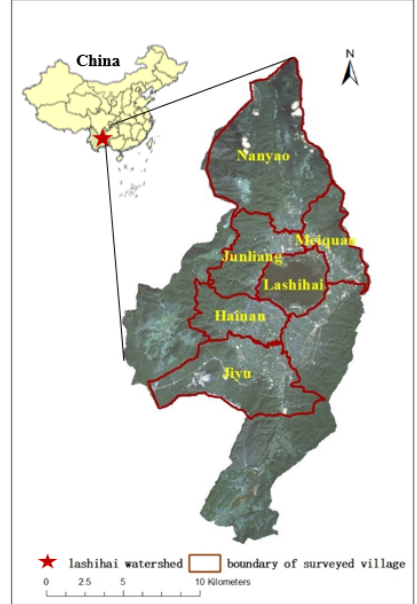
Figure 2. Map of Lashihai watershed and surveyed villages.